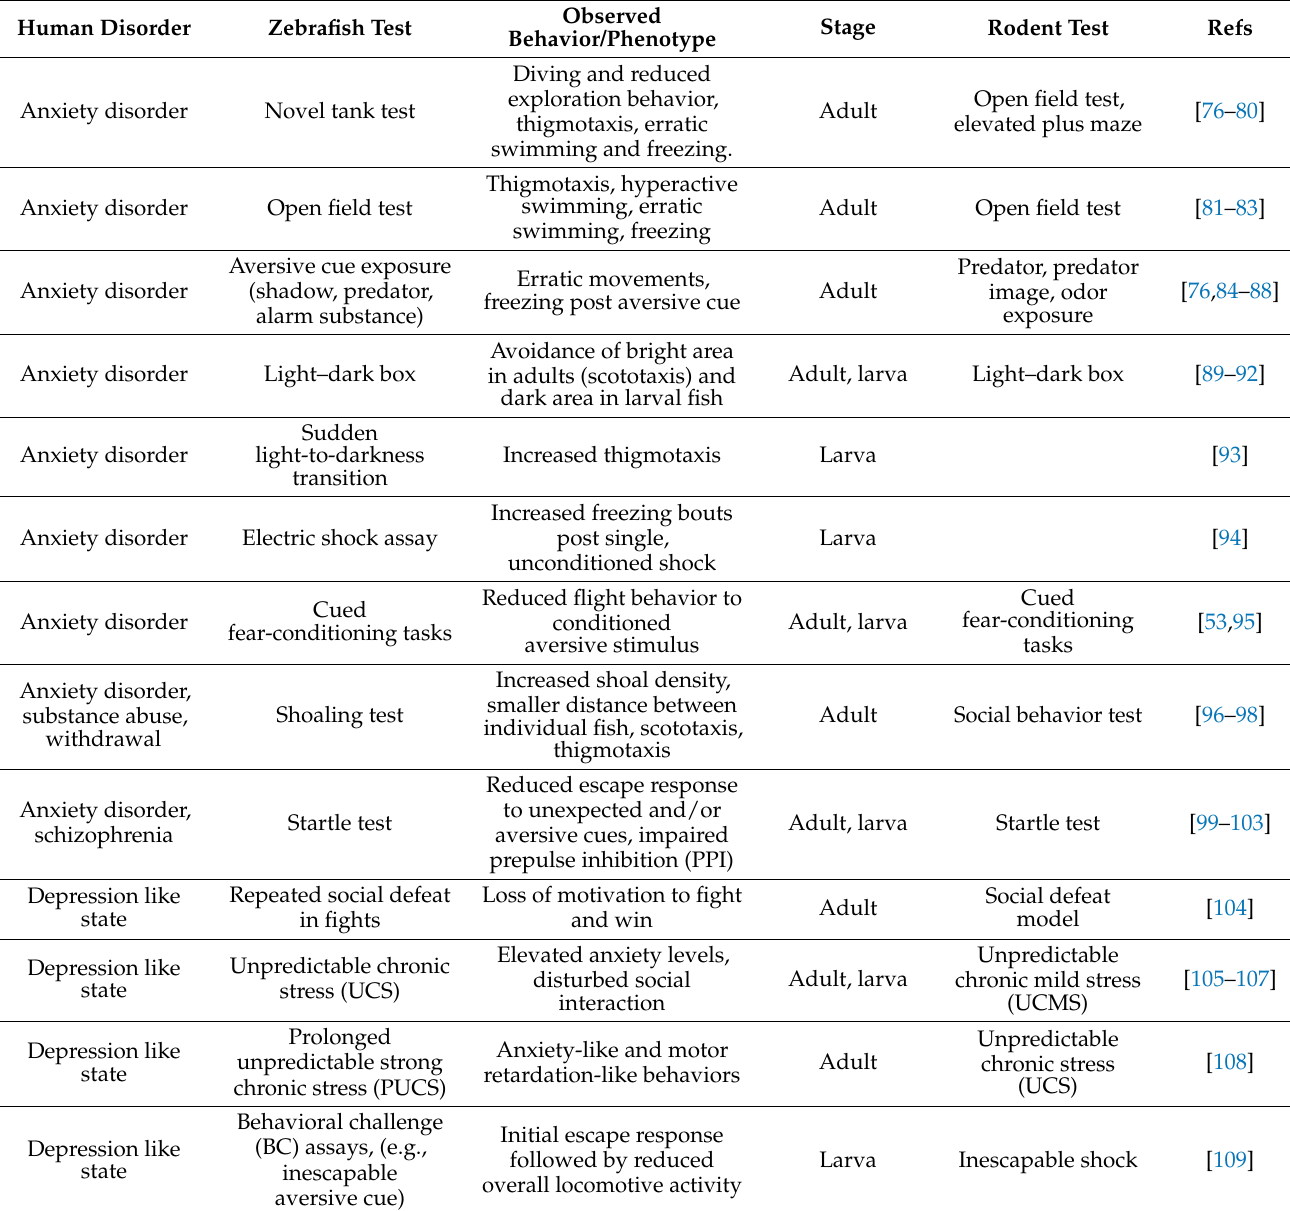
Table 1. Behavioral tests to study habenula linked